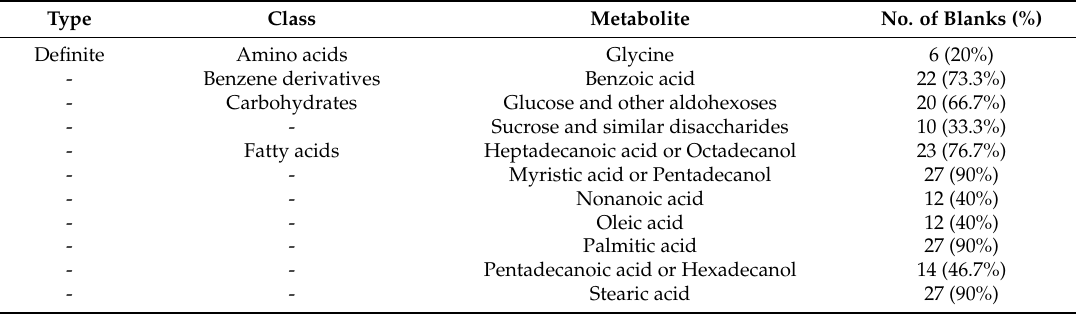
Figure 1. Contaminants represent 54% of all analytes detected. Classes of contaminants: process impurities (e.g., silicone oils and alkane hydrocarbons) present in blanks or discovered after manual curation (25), metabolites present in blanks (43), and unknowns present in blanks (88). Table 1. Metabolite contaminants detected in blanks by type (definite or potential) and chemical class. Detection rate in blanks varied by metabolite type.